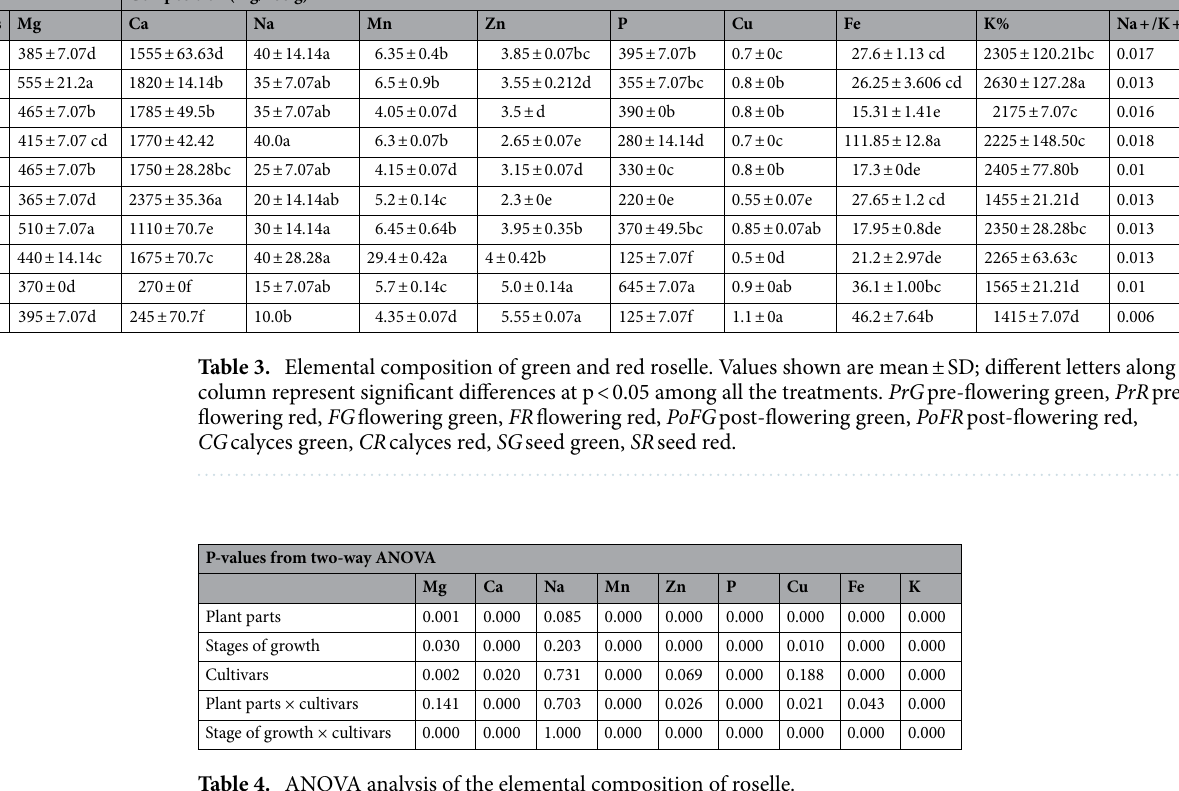
Table 4. ANOVA analysis of the elemental composition of roselle.